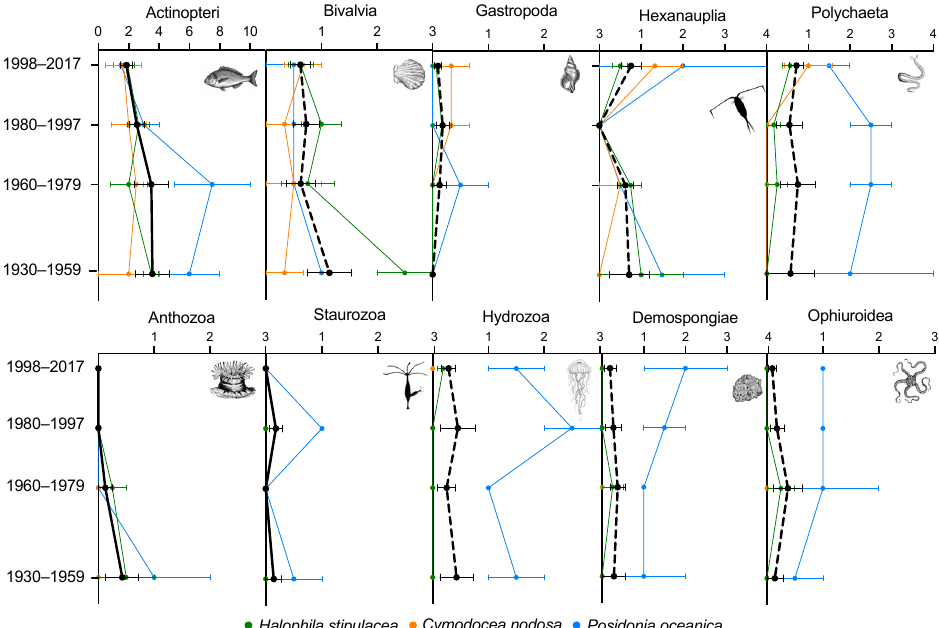
Figure 3. Temporal changes in richness (mean ± SE) in 10 metazoan classes within seagrass sediments ( H. stipulacea in green; C. nodosa in orange; P. oceanica in blue; overall of the three seagrass species in black) from the eastern Mediterranean Sea (Greece and Cyprus). Solid dark lines indicate significant differences between time intervals and dashed dark lines indicate non-significant differences ( p < 0.002 after Bonferroni correction), considering the three seagrass species combined.